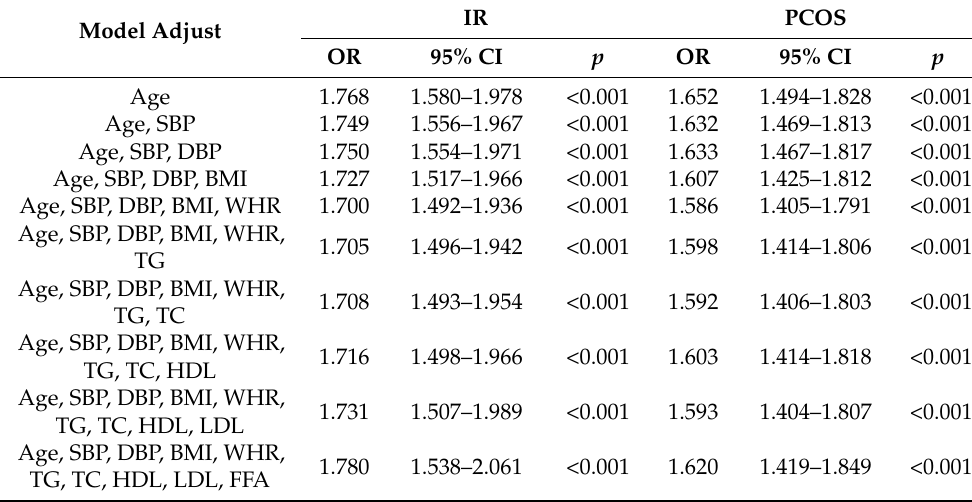
Table 2. Association of circulating HHIP with IR and PCOS in fully adjusted